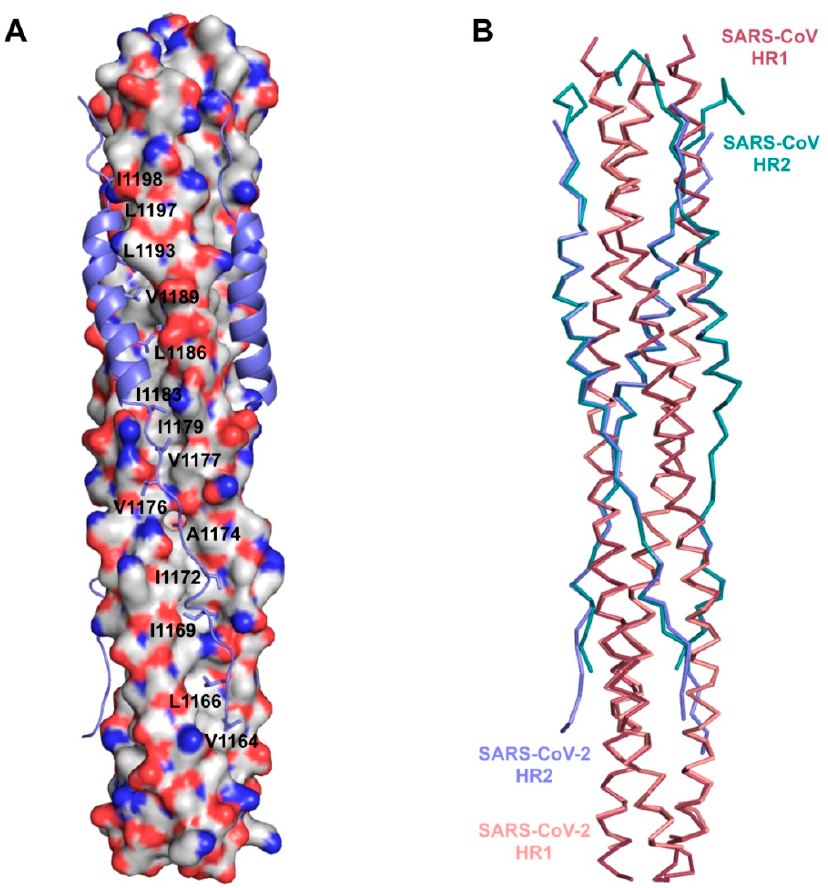
Figure 5. Structure of 6-HB fusion core in SARS-CoV-2. ( A ) The HR1 domain of SARS-CoV-2 is depicted as electrostatic surface, with hydrophobic residues in white, basic in blue, and acidic in red. The HR2 domain is shown in cartoon representation, with the hydrophobic residues in the central fusion core region shown as sticks and labeled. ( B ) The superposition of 6-HB structures of SARS-CoV-2 (PDB ID: 6LXT) and SARS-CoV (PDB ID: 1WYY), shown as ribbon. The HR1 and HR2 domains are colored salmon and slate for SARS-CoV-2, raspberry, and deep teal for SARS-CoV, respectively.